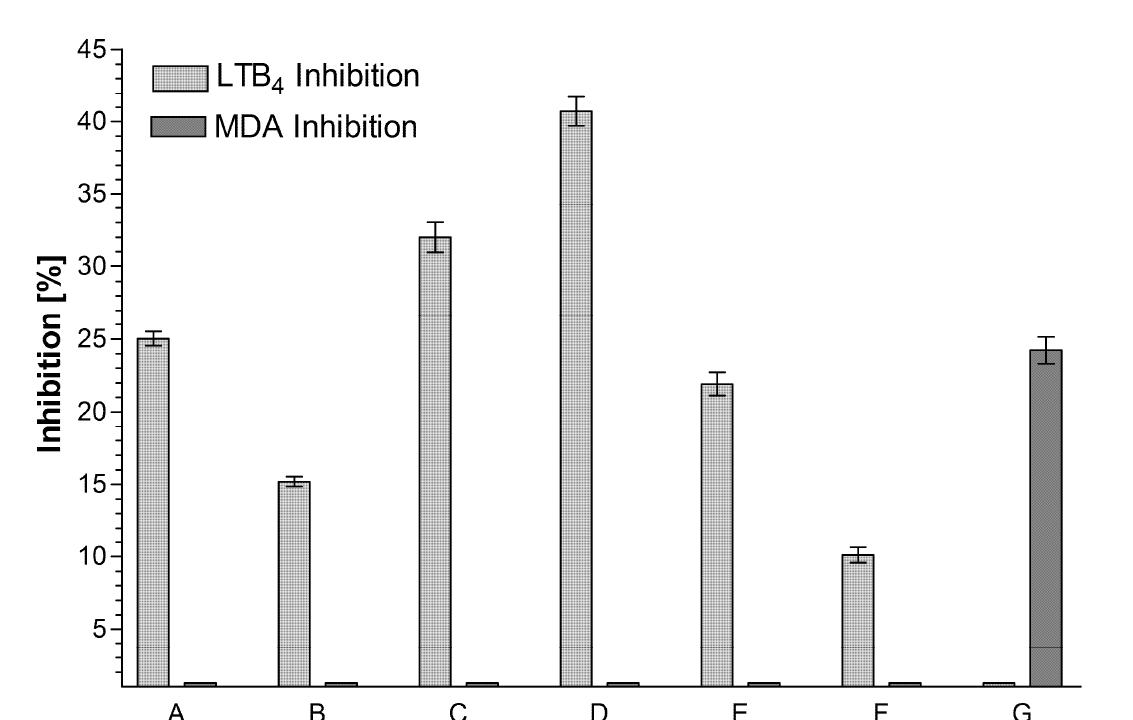
Figure 9. Inhibiting effect of the isolated Aloe polyketide constituents on the biosynthesis of the inflammation mediators LTB 4 and MDA in the above described in vitro test systems. Among these, only those that did display activity in at least one of the two test systems are depicted. All measurements were performed in triplicates at a concentration of 10 µM for all tested substances (for further details, see Materials and Methods). ( A ) aloin A/B (25.00% LTB 4 inhibition) ( 11 in Figure 1); ( B ) aloe emodin (15.00% LTB 4 inhibition) ( 10 in Figure 1); ( C ) 6 ′ - O -( E )-coumaroyl-aloin A (32.00% LTB 4 inhibition) ( 12 in Figure 1); ( D ) 6 ′ - O -( E )-coumaroyl-aloin B (41.00% LTB 4 inhibition) ( 13 in Figure 1); ( E ) 6 ′ - O -( E )-coumaroyl-7-hydroxy-8- O -methyl-aloin B (22.00% LTB 4 inhibition) ( 15 in Figure 1); ( F ) aloesin (10.00% LTB 4 inhibition) ( 4 in Figure 1); ( G ) 3 R -feralolide (24.00% MDA inhibition) ( 1 in Figure 1).